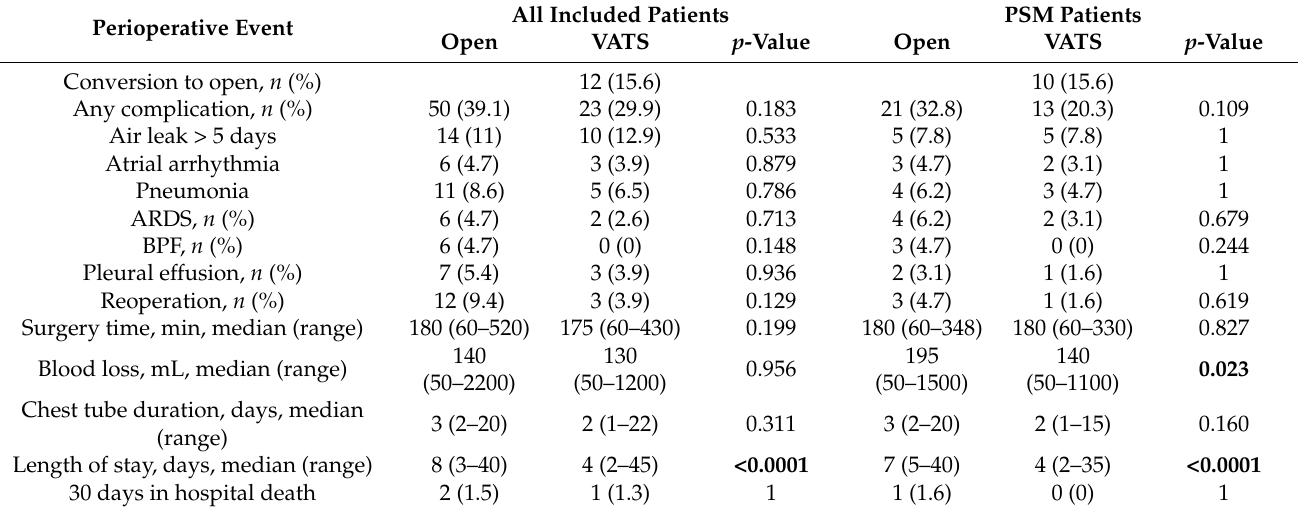
Table 3. Perioperative outcomes of all included patients and PSM pairs.